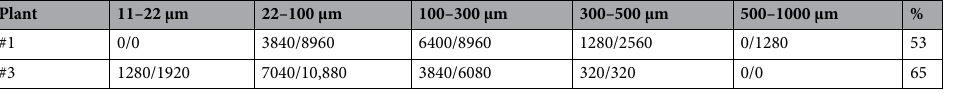
Table 3. Microplastic fragments (BDP/all) found per liter of liquid fertilizer. %: Percentage of BDP fragments within all recovered plastic fragments.